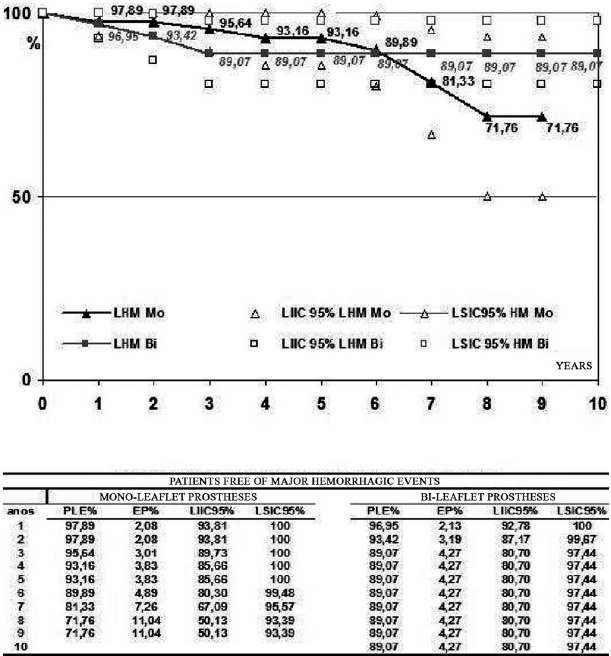
Fig. 6 - Curves and actuarial data showing the percentage of patients free of major bleeding events MBE (ordinate) with time-years (abscissa) for both types of prostheses studied. Mo = Mono-leaflet prosthesis; Bi = Bi-leaflet prosthesis; SE = standard error range; LLCI95% = lower limit of 95% Confidence Interval and ULCI95 % = Upper Limit of 95% Confidence Interval